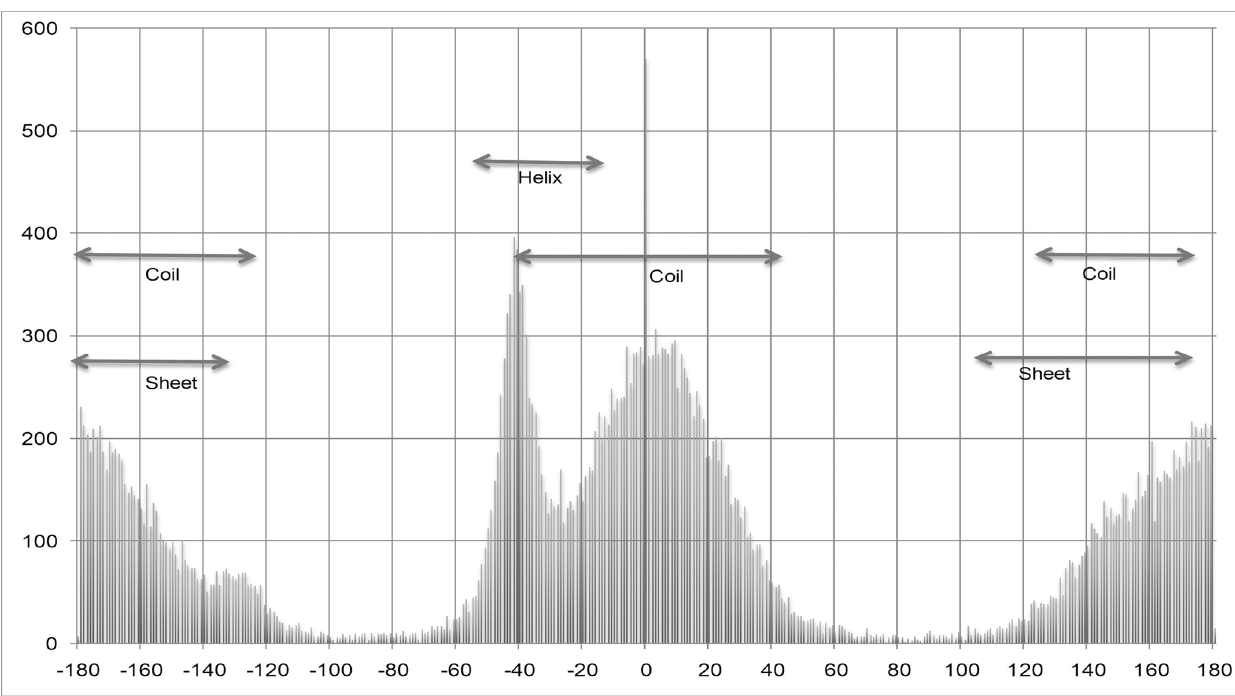
Figure 1. Normal psi angle distribution of glycine.